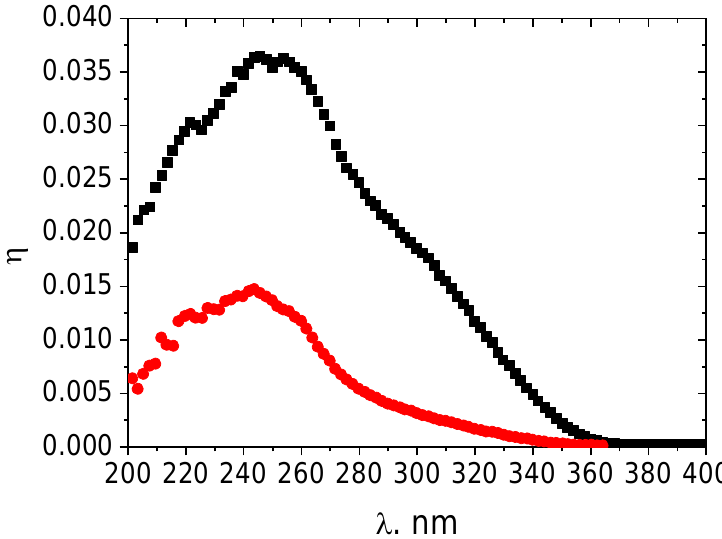
Figure 4. Spectral dependences of the quantum efficiency of a 4H-SiC photodetector with Schottky barriers: (1) initial sample and (2) sample irradiated with 167 MeV Xe ions at a fluence of 6 × 10 9 cm −2 . Room temperature.